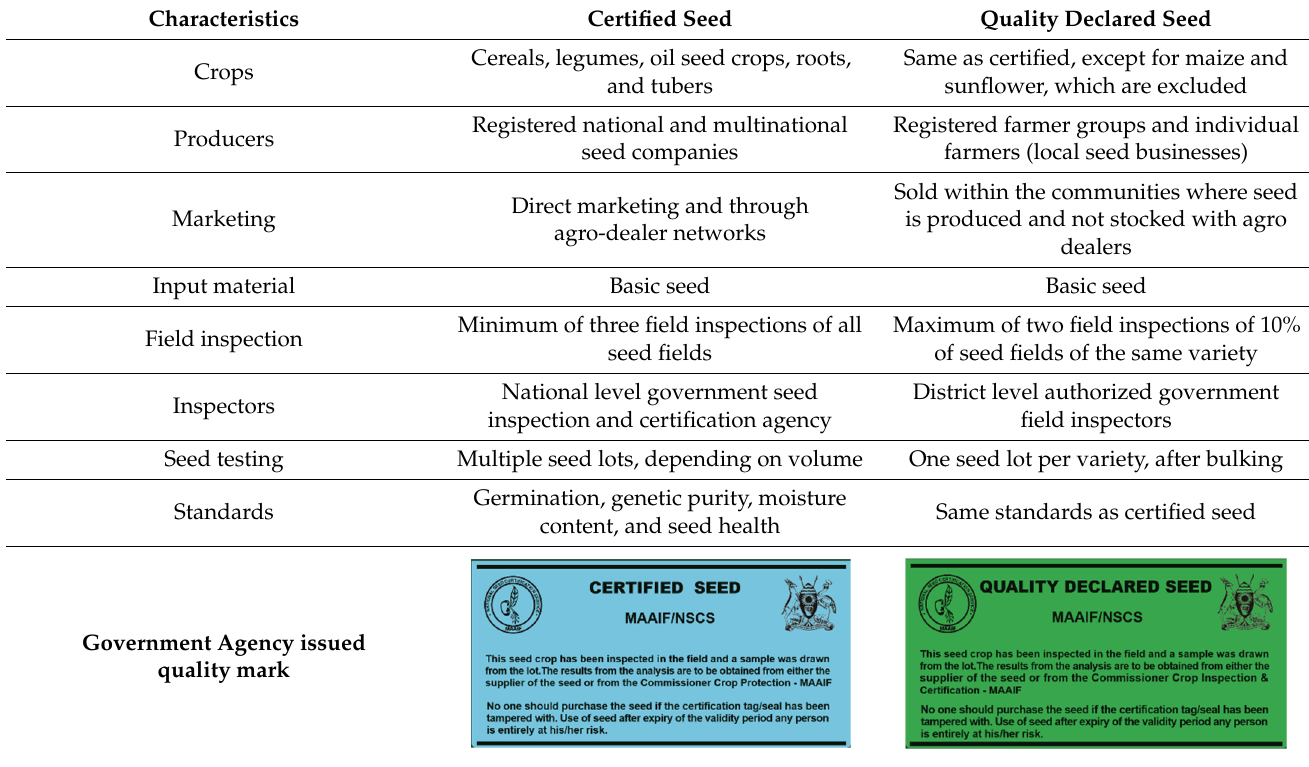
Table 1. Summary characteristics of certified seed and QDS classes in Uganda.